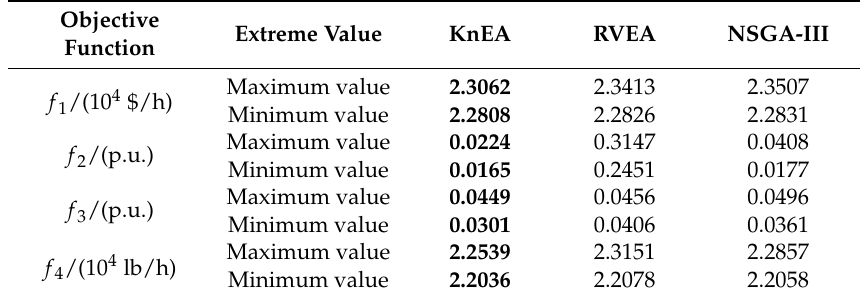
Table 1. Comparison of extreme values of KnEA, RVEA, and NSGA-III. (KnEA: knee point-driven evolutionary algorithm; RVEA: reference vector guided evolutionary algorithm; NSGA-III: non-dominated sorting genetic algorithm III).